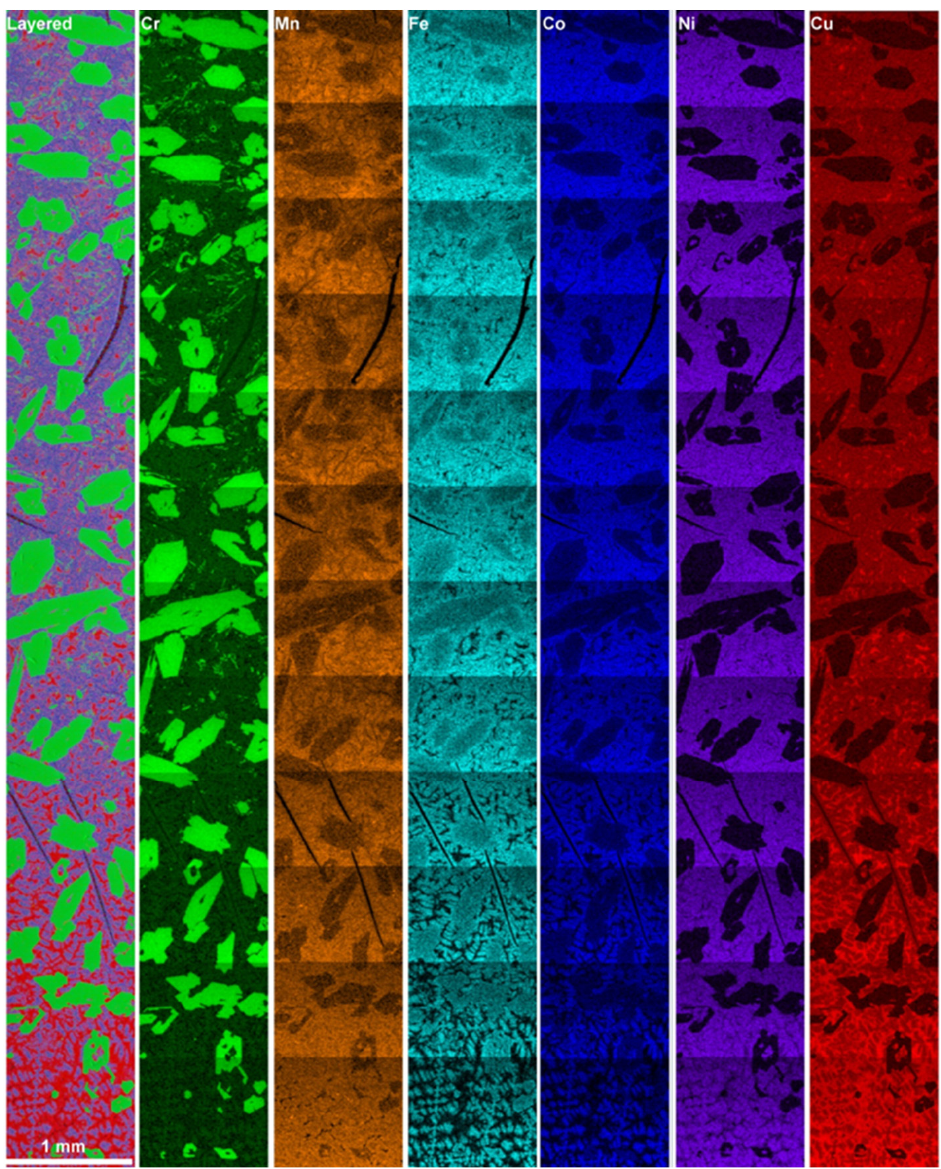
Figure 8. Image-stitched layered EDS elemental map of a 1 mm wide cross-section from bottom to top, with constituent elemental maps of Cr, Mn, Fe, Co, Ni, and Cu, respectively. Table 4. Nominal (planned) versus actual (measured) compositions of the cast ingot. Element Planned